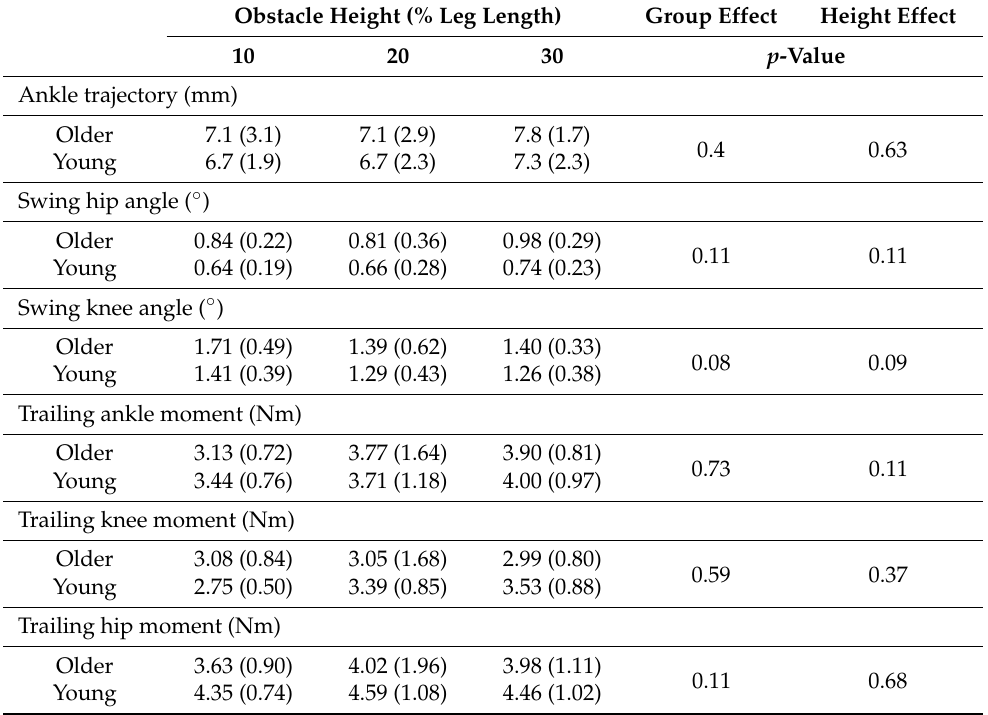
Table 3. Means (standard deviations) of the RMSEs of the kinematic data of the leading swing limb and the trailing joint moments between the best-compromise solutions of the Multi-Objective Optimal Control (MOOC) and the experimental